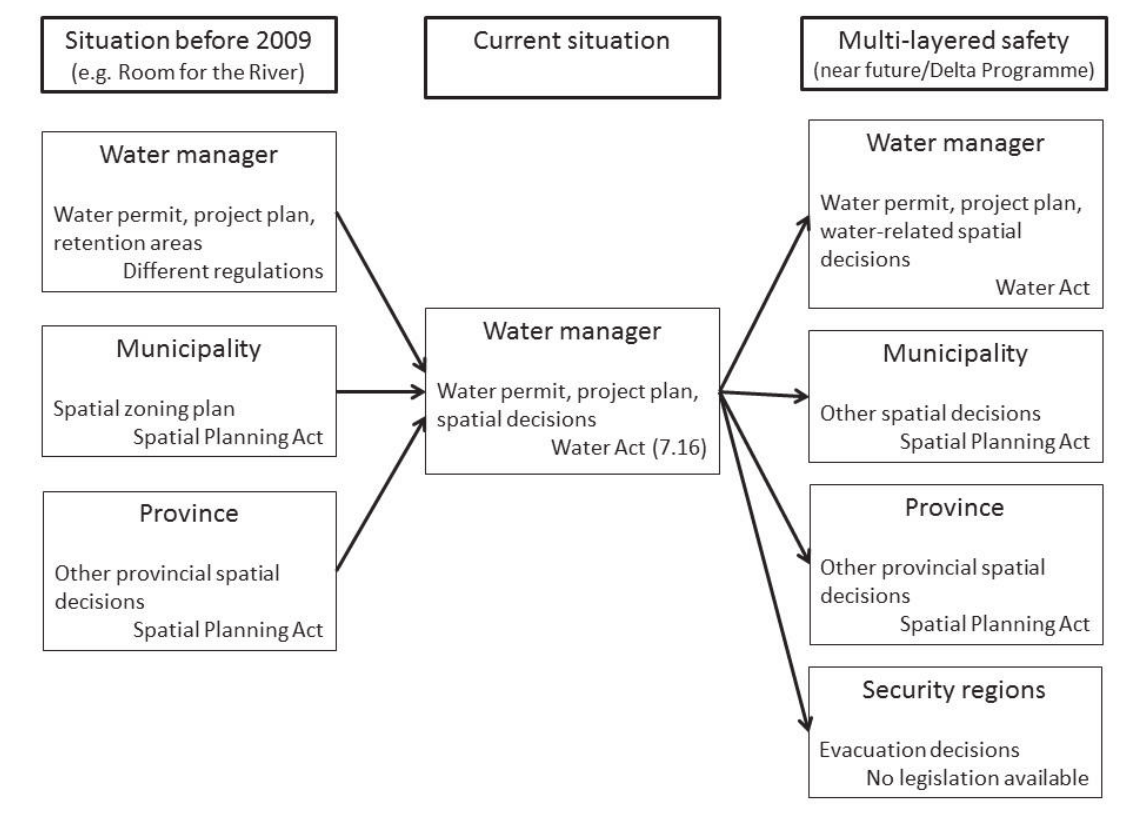
Figure 6 Shift of compensation regimes in view of developments in flood risk